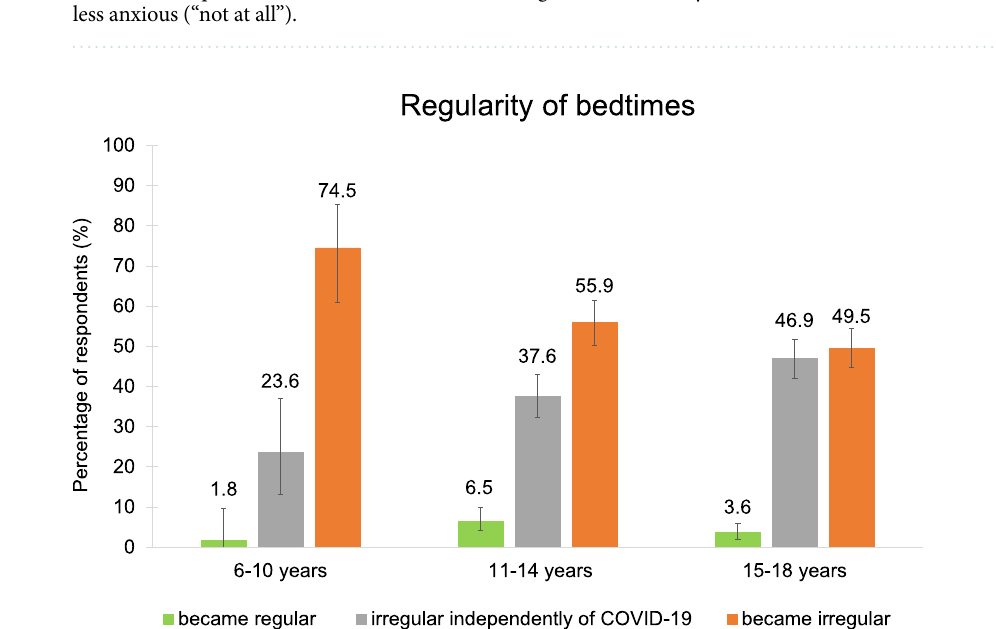
Figure 6. Changes in regularity of bedtimes. Especially for 6–10-year-olds, bedtimes became irregular during